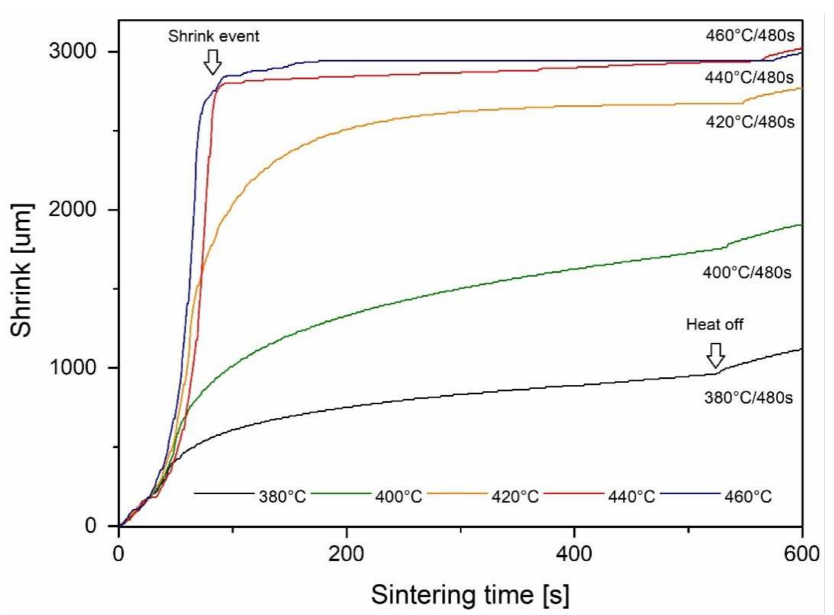
Figure 3. U-FAST process readout.